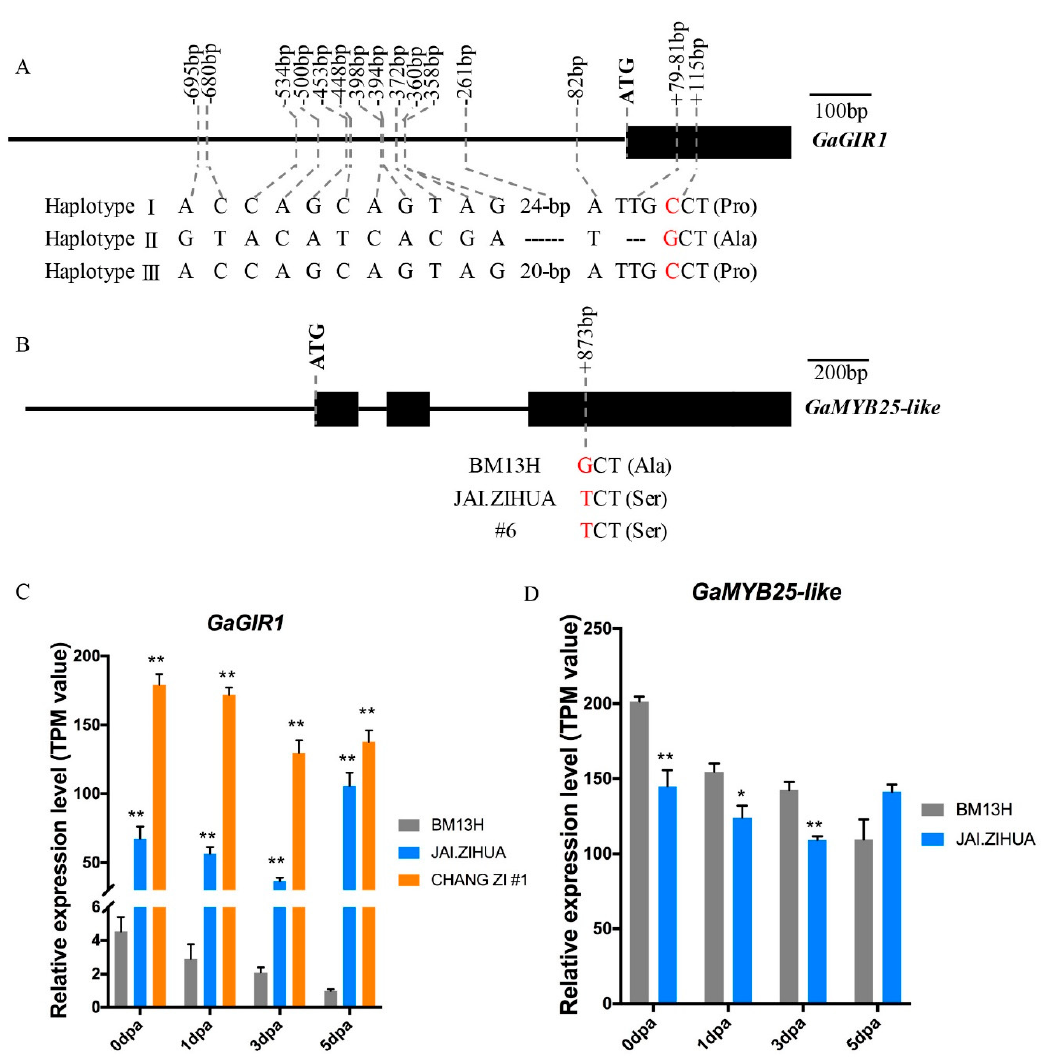
Figure 5. Comparison of GaGIR1 and GaMYB25-like between BM13H and the fuzzless accessions. ( A ) Sequence comparison of the promoter and ORF regions of GaGIR1 in different accessions. Only nucleotides different to BM13H are shown and SNPs that result in amino acid changes are in red. Haplotype I is BM13H. Haplotype Ⅱ contains accessions #47, NANTONG, #6, NAN.GINGJING, and